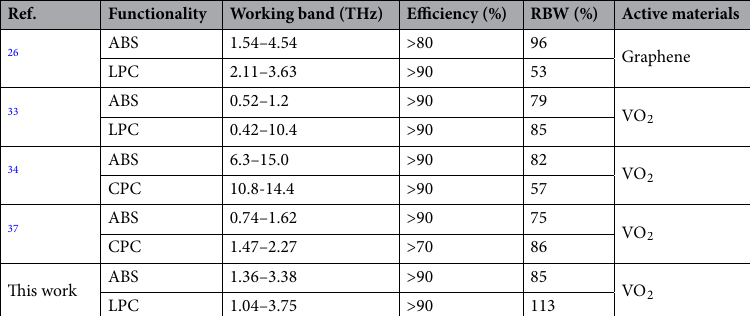
Table 1. Comparison with the existing state-of-the-art RMSs in THz range.